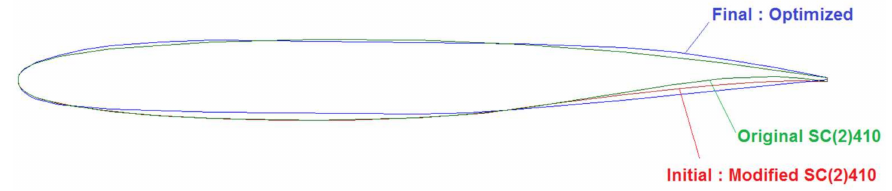
Figure 3. The initial airfoil versus the final optimized